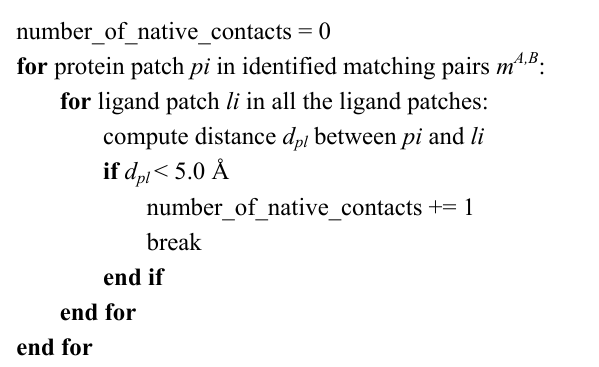
Figure 8. Pseudo-code for computing the maximum number of native